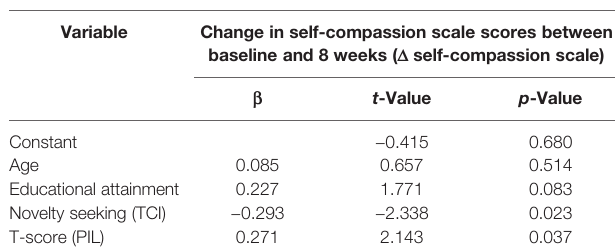
TABLE 3 | Multiple regression analysis showing the effects of age, educational attainment, novelty seeking, and purpose in life score on change in self- compassion during an 8-week mindfulness-based intervention ( n =